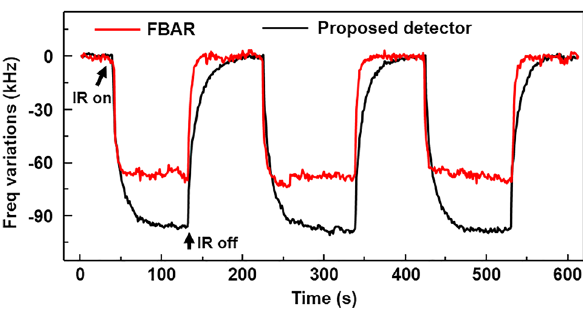
Figure 4: (a) Frequency response to different infrared (IR) intensities. (b) Responsivity of the proposed sensor with a sensing area of 15,000 μ m 2 is evaluated to be 1.65 kHz/( μ W/mm 2 ), also equivalent to 100 Hz/nW.